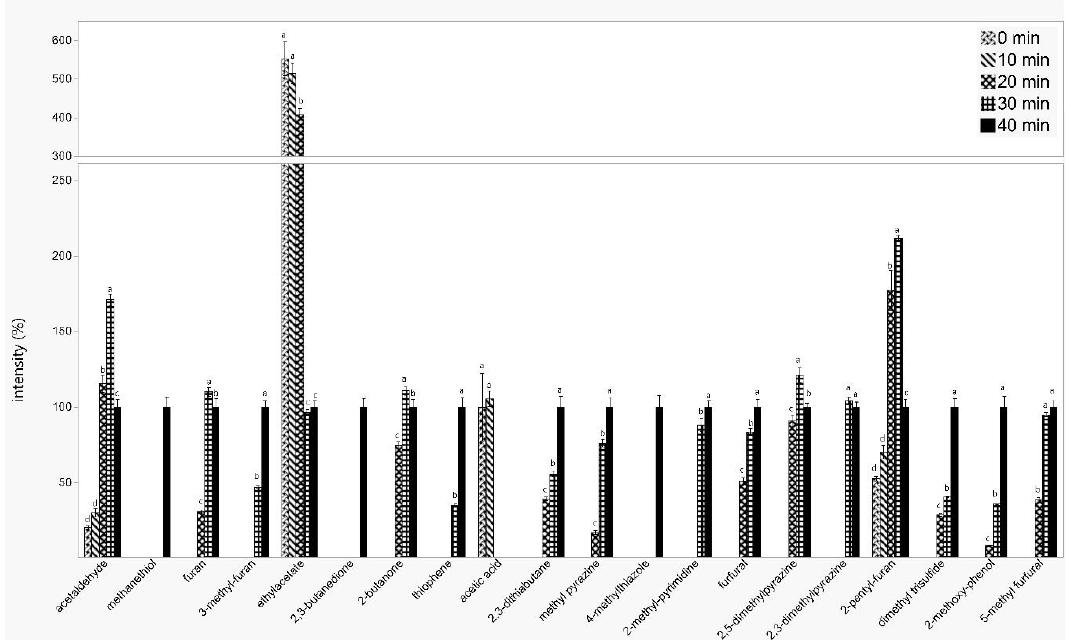
Figure 3. Volatile compounds of cactus seed oil after roasting of the seed material and extraction of the oil. Shown are the relative amounts in comparison to 40 min of roasting (100%), except for acetic acid (100% ≙ 0 min) (Mean ± SD, n = 3). Values with different letters are significantly different in comparison to the other time points by applying Tukey–Kramer HSD test ( p < 0.05).